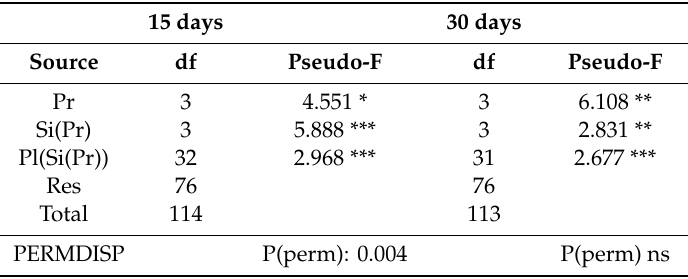
Table 1. Multivariate analysis of variance of total biofilm assemblage across “Pressure” levels (Pr) and “Sites” (Si(Pr)) after 15 and 30 days of “Panel” (Pl(Si(Pr))) deployment. Analyses are based on Bray–Curtis similarity matrices of untransformed data; df, degrees of freedom.